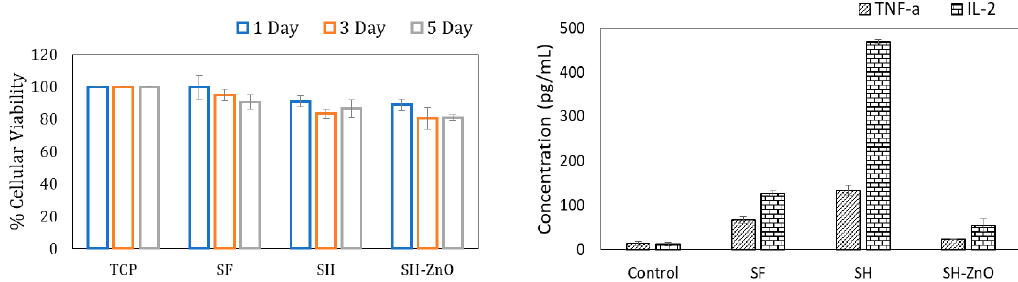
Figure 7. MTT assay and expression of TNF- α and IL-2 by SF, SH, and SH-ZnO.